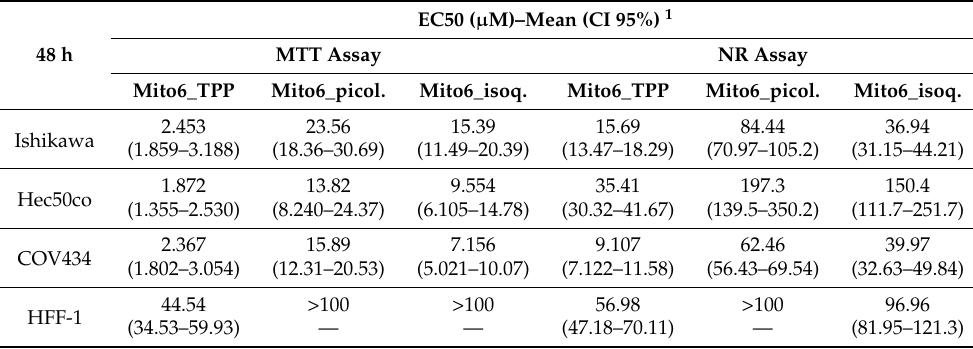
Figure 3. Viability assessed by the methylthiazolyldiphenyl-tetrazolium bromide (MTT) assay of Ishikawa ( a ), Hec50co ( b ), COV434 ( c ), and HFF-1 ( d ) cells treated with Mito6_TPP, Mito6_picol., or Mito6_isoq. (0.01–100 µ M) at 48 h of incubation. Untreated cells containing only the respective cell medium and 2% Foetal Bovine Serum (FBS) were used as control and are represented as a dotted line at 100%. Results are compared to the control and expressed as mean ± SEM of at least three independent experiments performed in triplicate. Significant differences between treated and untreated cells are described as * ( p < 0.05), ** ( p < 0.01), and *** ( p < 0.001). Table 1. The EC50 values of Mito6_TPP, Mito6_picol., and Mito6_isoq. in Ishikawa, Hec50co, COV434, and HFF-1 cells at 48 h of incubation. The values were calculated by interpolation in GraphPad Prism using the decrease of viability obtained through the MTT or the NR